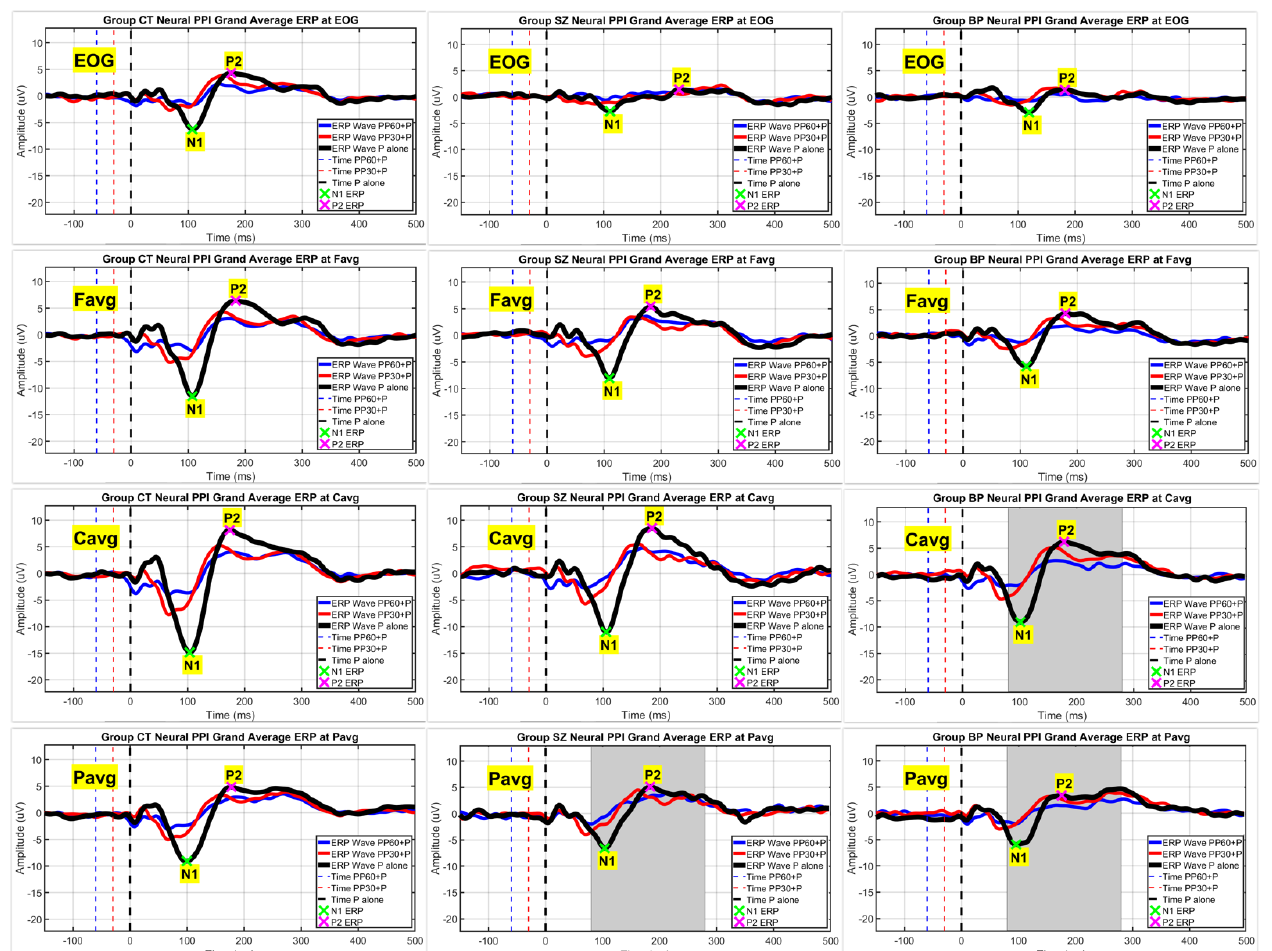
Figure 4. Grand averaged waveforms (after artifacts removal) of from CT, SZ, and BP groups (column subfigures) for the conditions pulse alone (P) and PP + P (30 and 60 ms) at EOG, Favg, Cavg, and Pavg (line subfigures). The N1 and P2 ERPs (green and magenta crosses, respectively) were signalized only for the pulse P condition (black lines), but grand averaged waveforms were also displayed for the PP + P conditions at Prepulse-Pulse intervals of 60 and 30 ms (blue and red lines, respectively), which were the only conditions were significant differences (highlighted in grey color) with the CT group were found in the neural PPI.